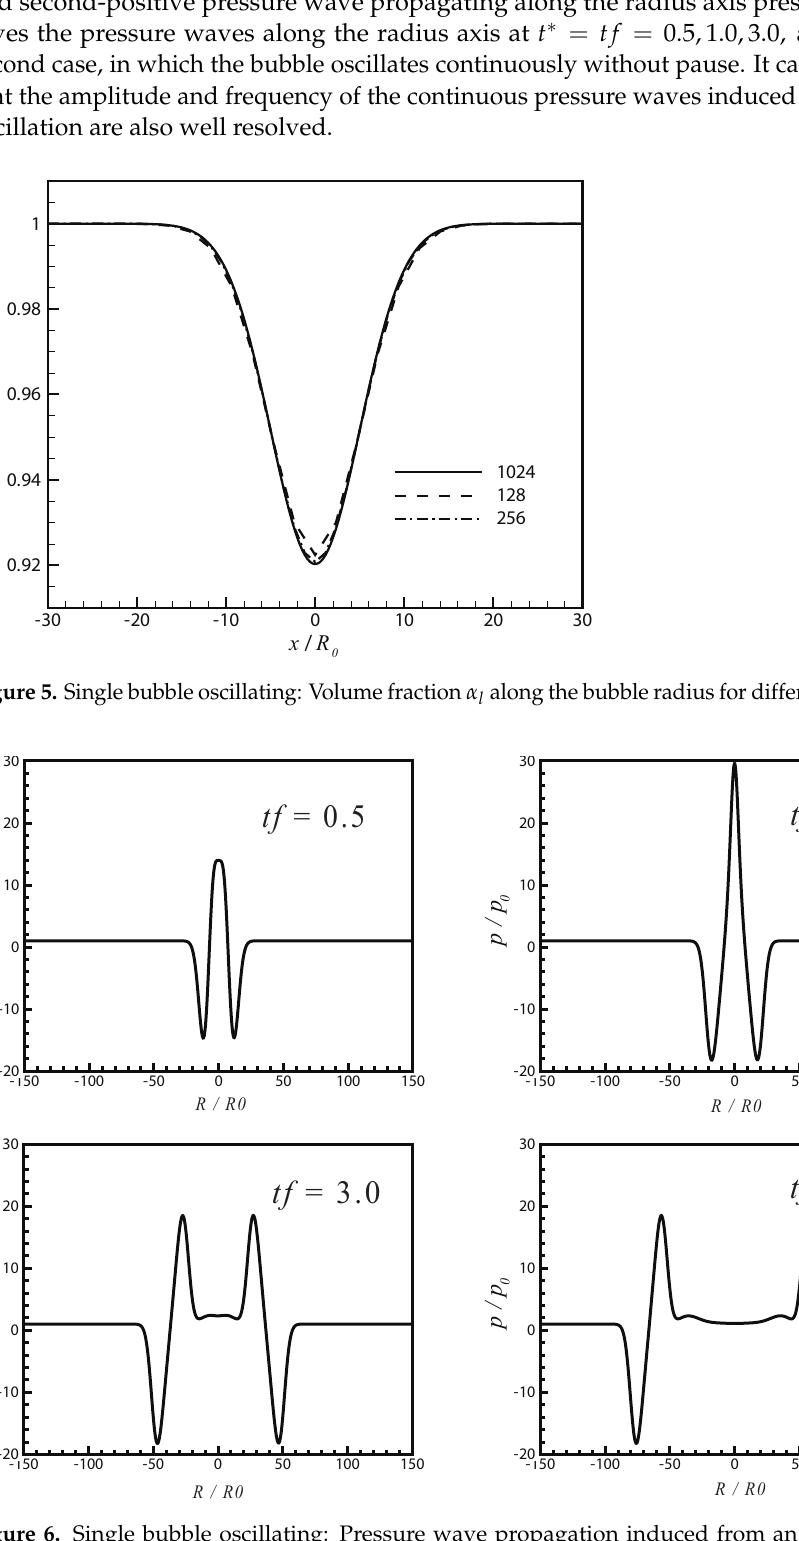
Figure 6. Single bubble oscillating: Pressure wave propagation induced from an oscillating gas bubble at t ∗ = tf = 0.0,1.0,3.0, and